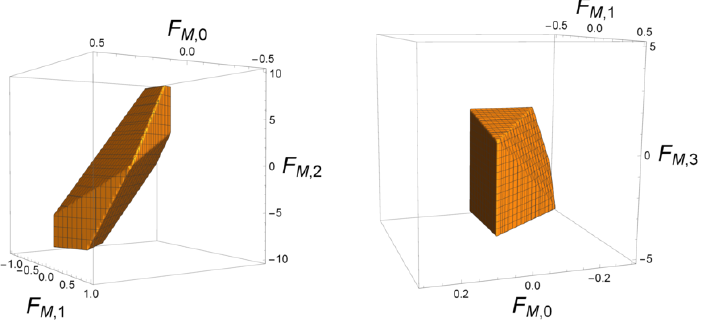
Figure 24 . Representative cases for three M -type operators. Allowed parameter spaces are de- scribed by pyramids.